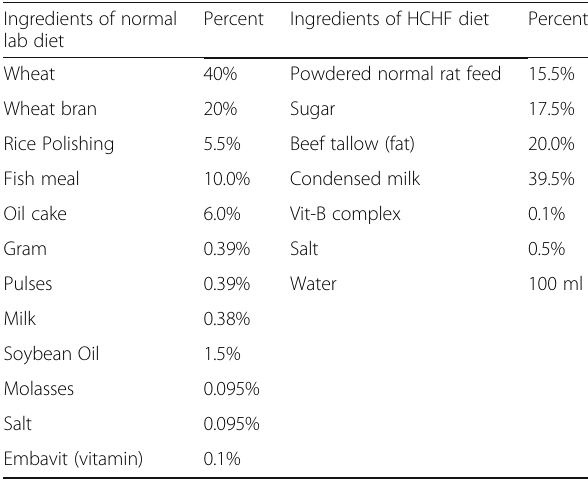
Table 1 Composition of normal and high carbohydrate high fat diet used in this study (for 100 g) Ingredients of normal lab